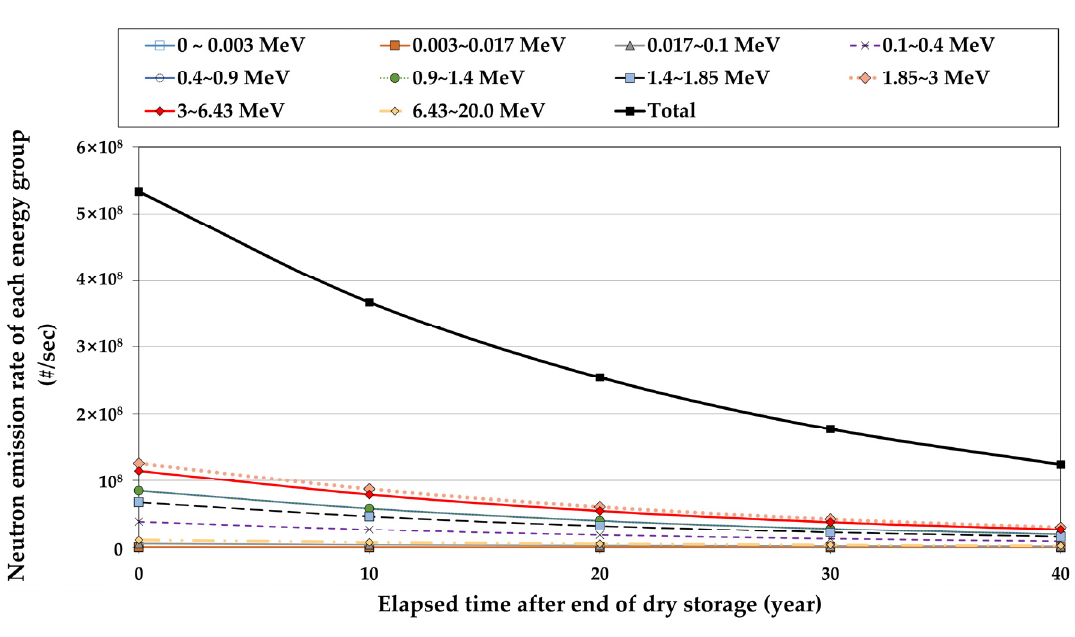
Figure 3. Neutron emission rate of each energy group from an assembly of SNF in the reference case.